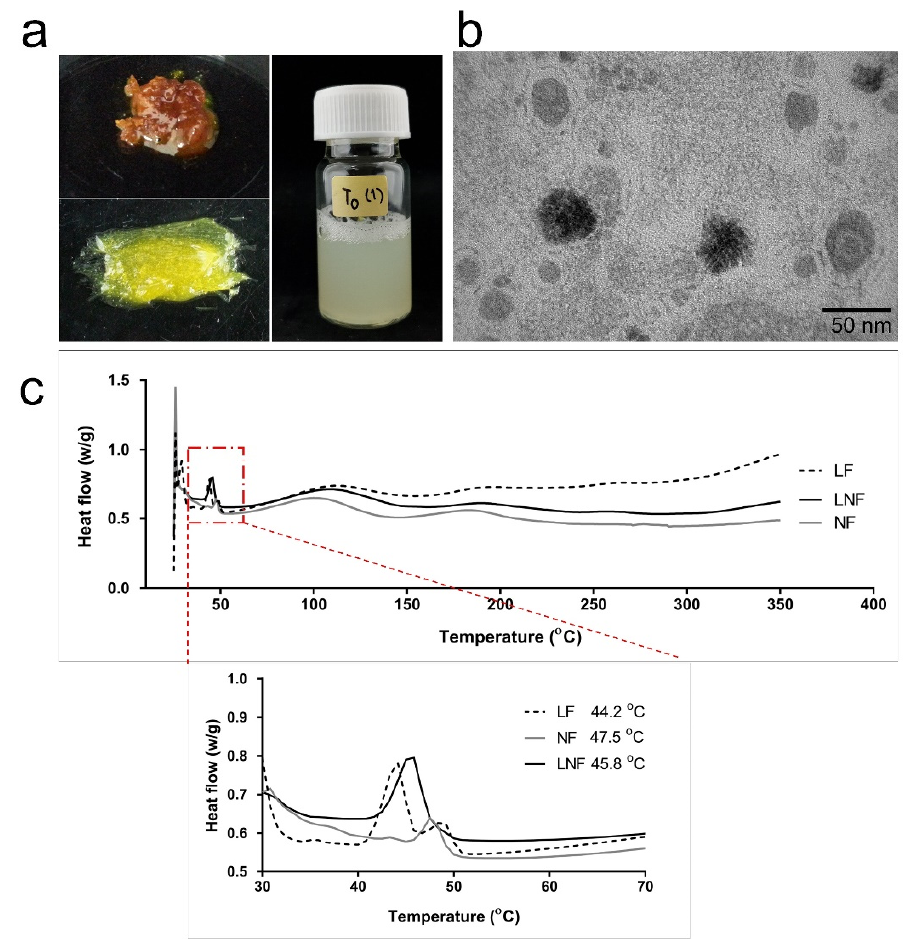
Figure 3. Physical appearances of fenugreek extract and liponiosome encapsulating fenugreek extract (LNF): ( a ) (Upper left) fenugreek extract form, (lower left) LNF paste form, and (right) 1% in water solution. ( b ) Physicochemical characterization of formulated nanoparticles showing a transmission electron microscope (TEM) image of LNF. ( c ) Physicochemical characterization of formulated nanoparticles showing a differential scanning calorimeter (DSC) graph of LNF compared to LF and NF. Table 3. Physicochemical properties of formulated